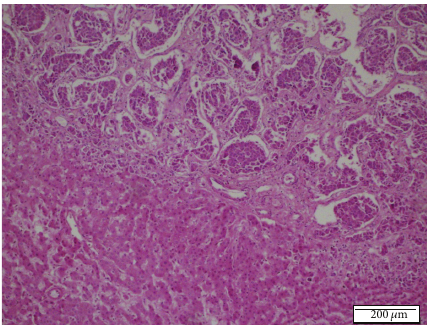
Figure 4: Histopathologic appearance of tumoral lesion in the resected liver specimen. Microscopic characteristics are similar in first and second Tru-Cut biopsies. H.E. × 100.